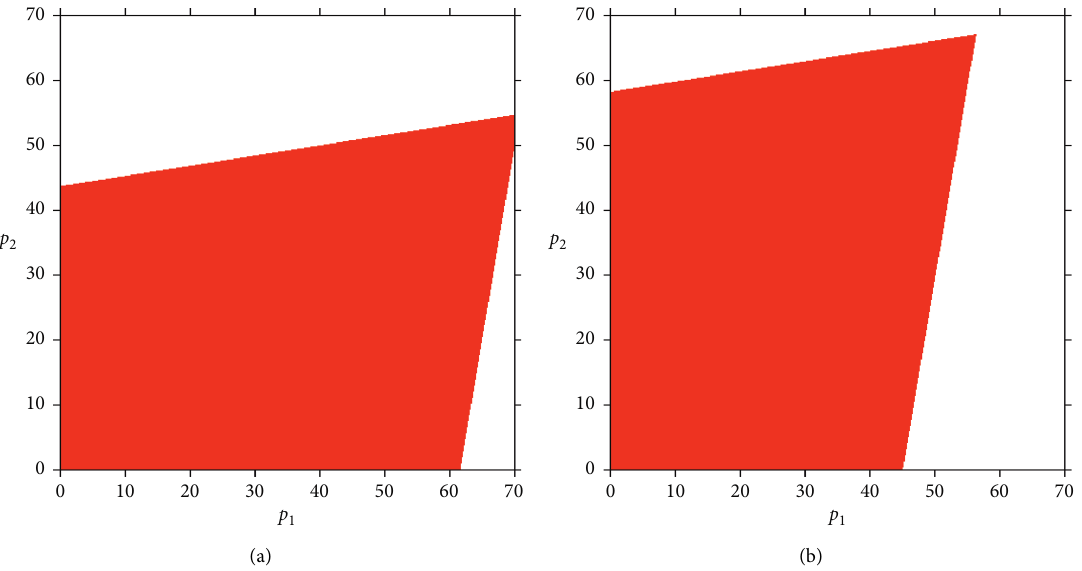
Figure 8: Basins of attraction with v